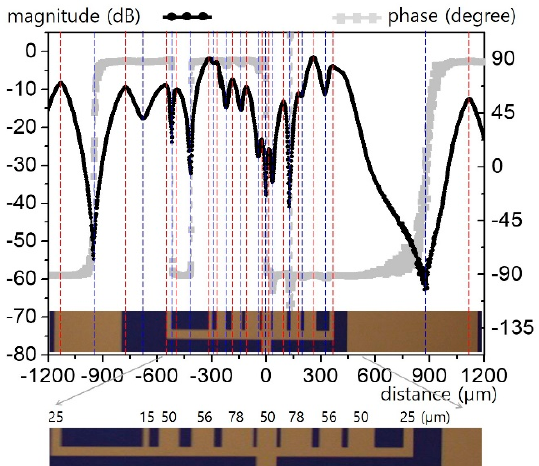
Figure 9. Horizontal electric field distribution over an arbitrary CPW ( n = 10; detailed dimensions are given at the bottom).